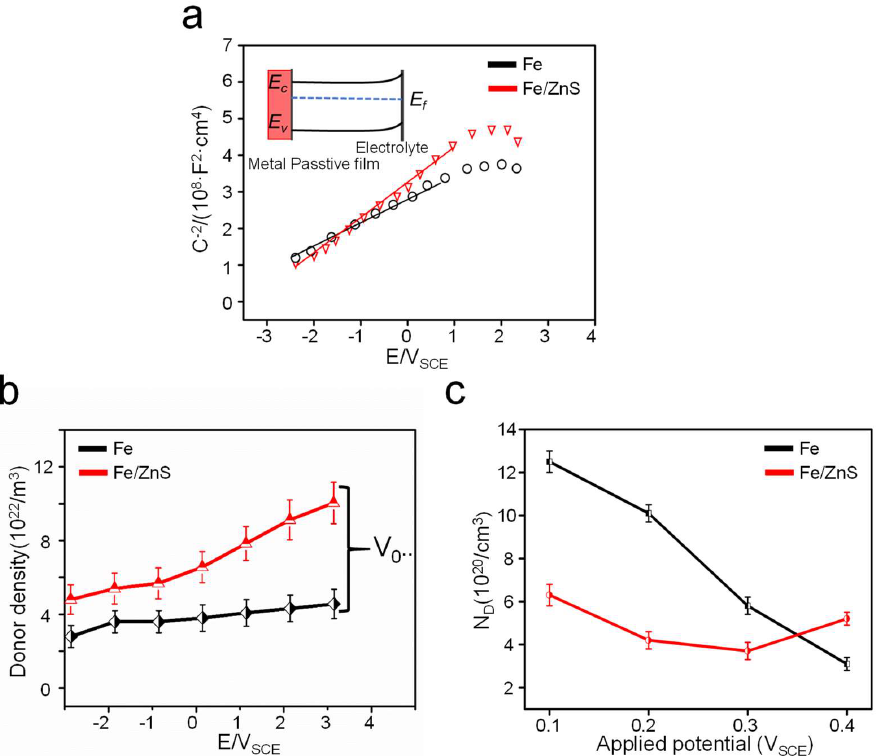
Figure 8. ( a ) Mott-Schottky results of Fe and Fe/ZnS composite in SBF solution, ( b ) the oxygen vacancy density variation of passive film, and ( c ) the calculated defects density of the passive film.